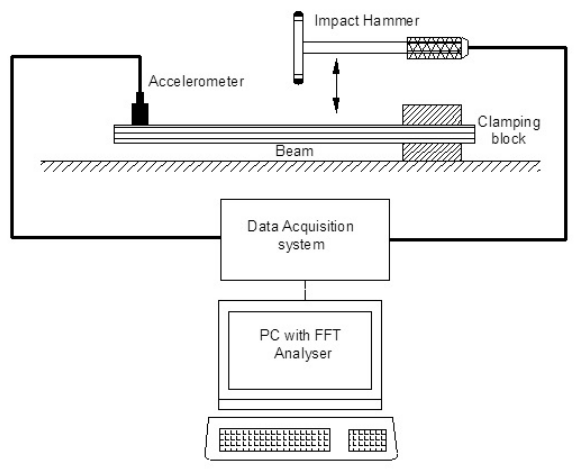
Fig. 6. Schematic diagram of free vibration test